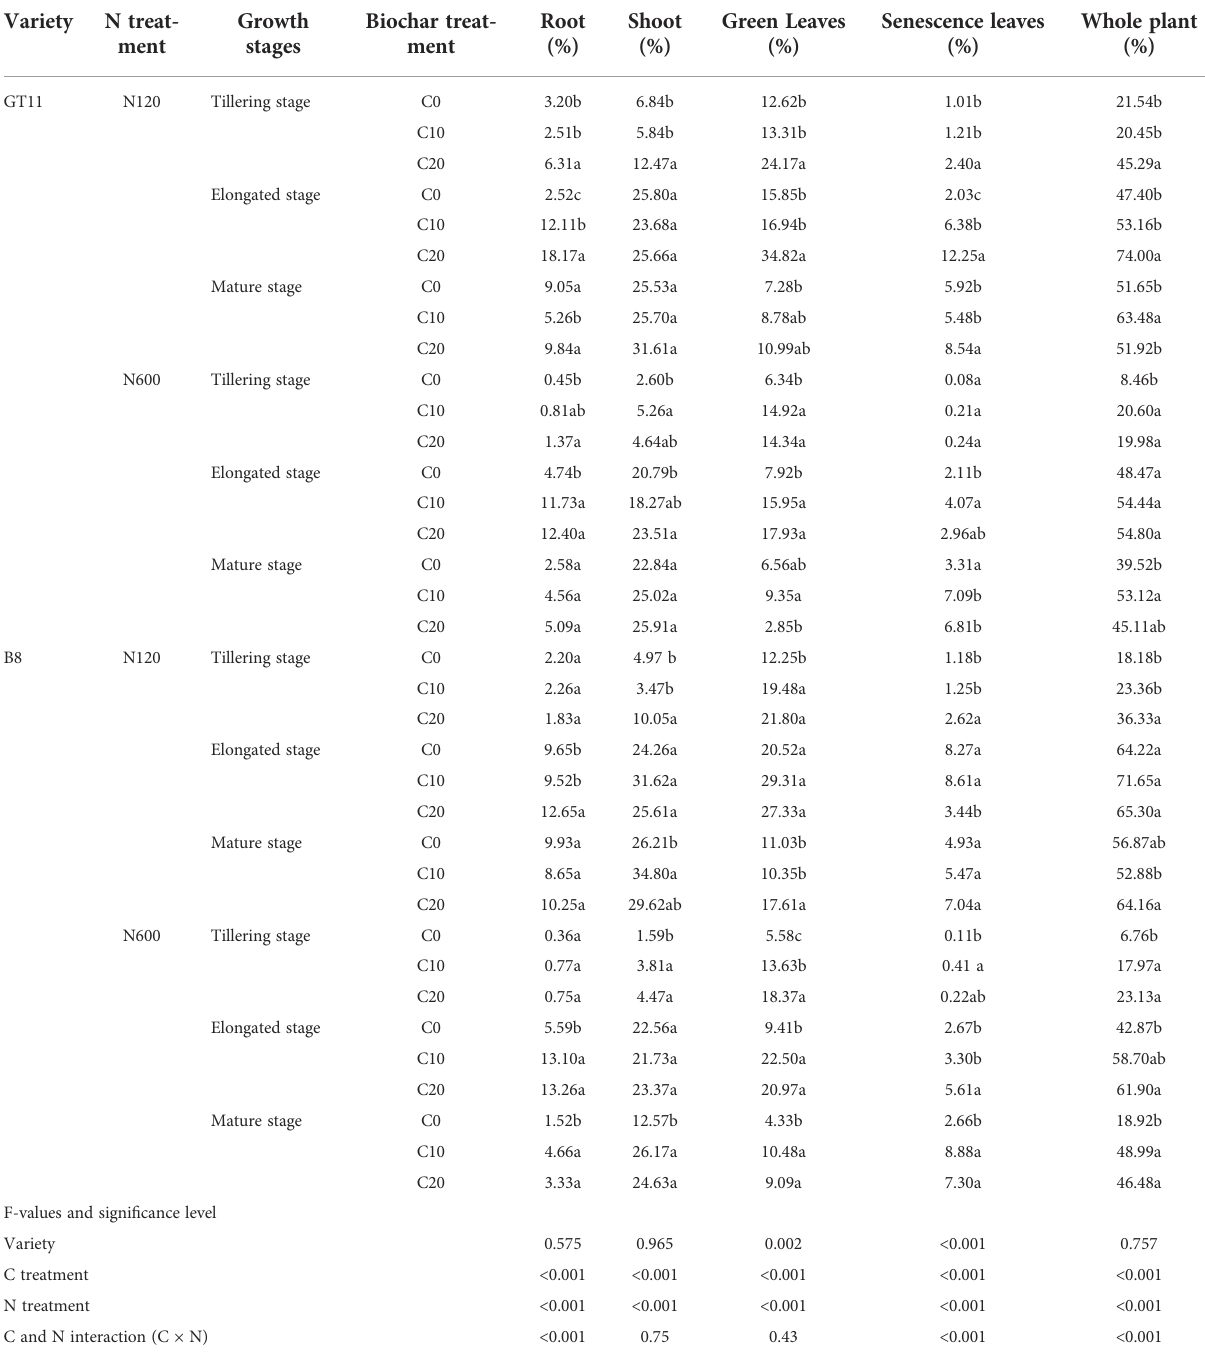
TABLE 4 Effects of biochar and N fertilizer treatment on N use ef fi ciency of two sugarcane varieties. Variety N treat- Growth Biochar treat- ment stages